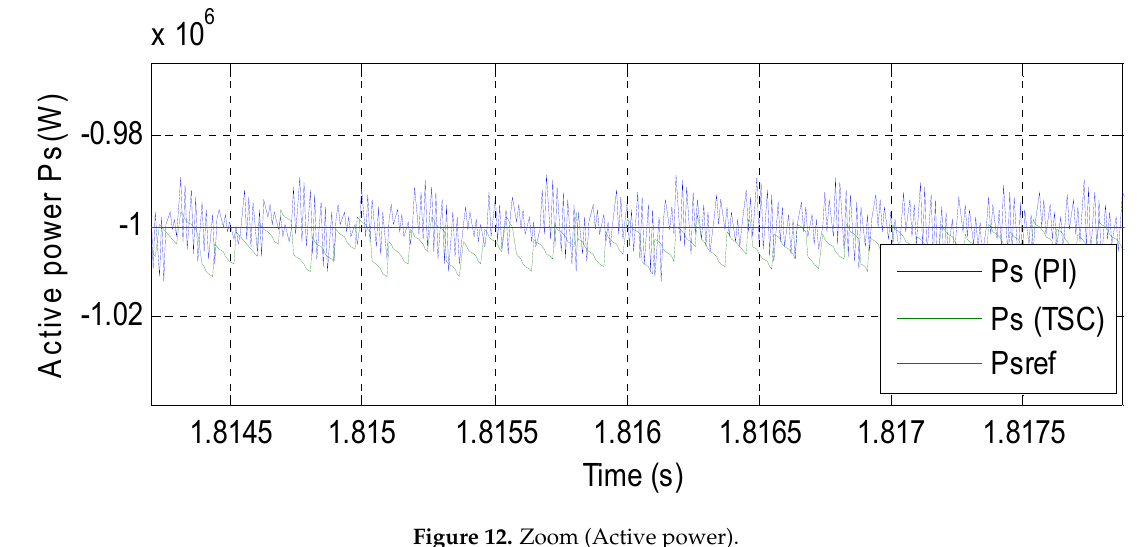
Figure 11. Current.